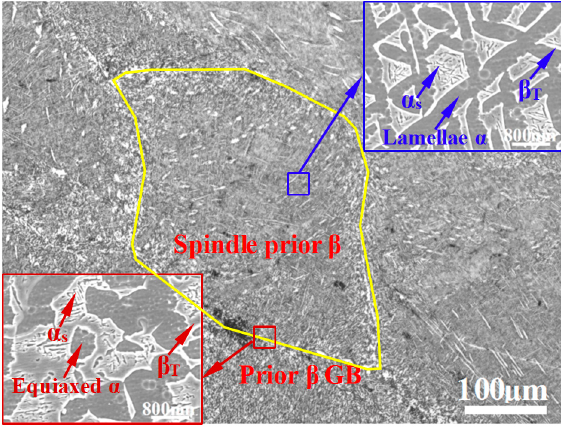
Figure 4. Microstructure of the heat-treated titanium alloy.